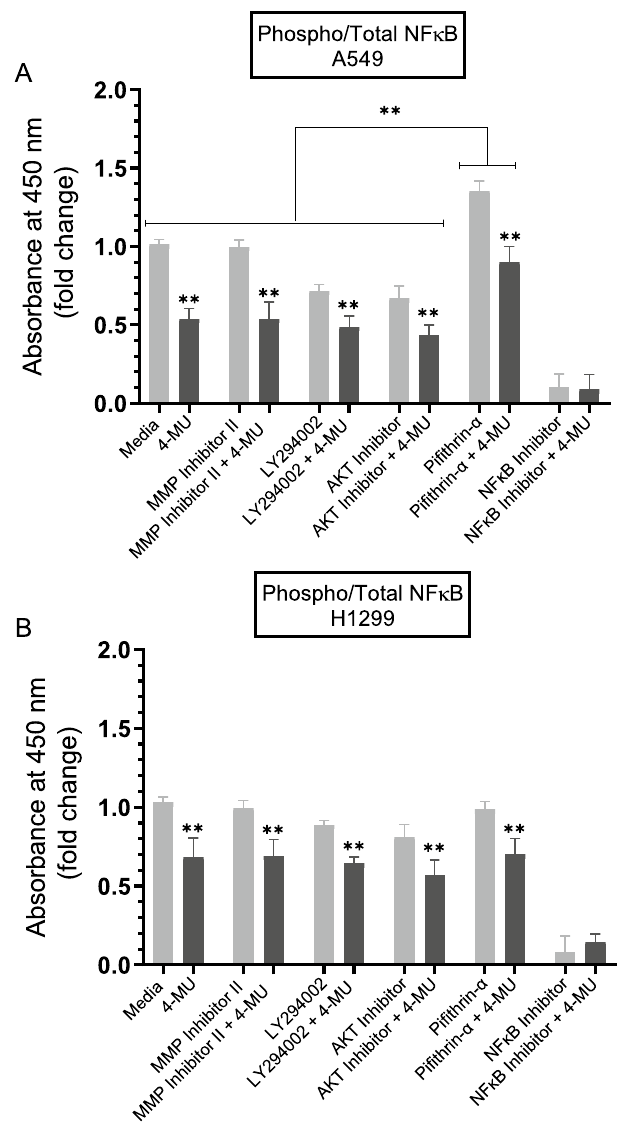
Figure 6. Phospho/Total NFκB ratio is increased upon treatment of A549 cells with the p53 inhibitor, pifithrin-α. Cells (0.2 × 10 5 ) were grown in 10% FBS-supplemented media for 24 h. The following day, the cell monolayers were incubated in serum-free media for 24 h, then treated as indicated for 72 h with the inhibitors without and with 600 µM 4-MU as described in the “Methods” section. The cell lysate was prepared and the same amount of protein (600 µg/mL total protein) of each sample was used to assay for NFκB activity as described in the “Methods” section. Data from five independent assays, each performed in triplicate, were quantitated, averaged, normalized, and expressed as fold change relative to cells not treated with 4-MU using the GraphPad 8.4.3 software. The graphs summarize the results expressed as means ± SD (n = 5). Asterisks (*) indicate a statistically significant difference from the corresponding samples without 4-MU treatment for each cell line, Mann–Whitney test, while the absence of asterisks indicates no significance. Statistical differences between different groups were analyzed by an ordinary one-way analysis of variance (ANOVA) followed by Tukey’s post-hoc multiple comparison test. ** p <